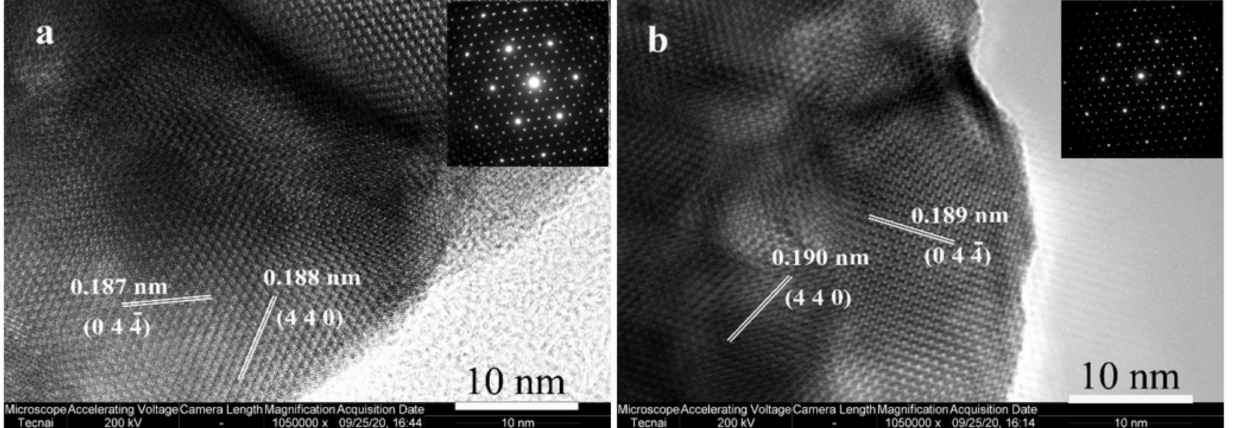
Figure 6. High resolution (HR) TEM graphs of Ho 2 O 3 -NS ( a ) and 0.04Sr-Ho 2 O 3 -NS ( b ). Insets are the fast Fourier transfer (FFT) patterns of the HR-TEM